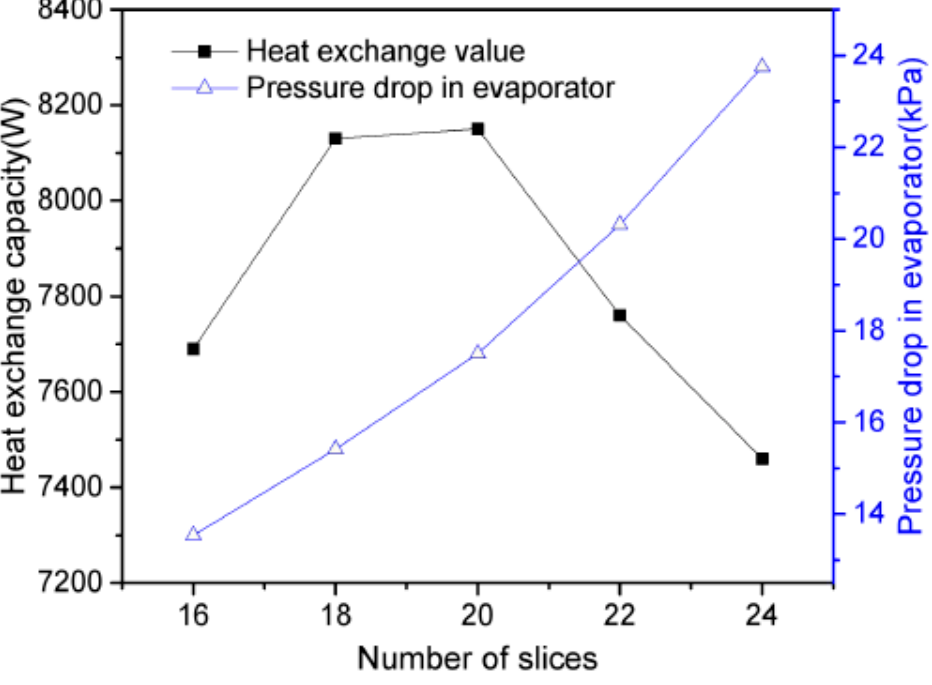
Figure 15. The heat exchange capacity and the pressure drop in the evaporator vary with the number of slices.